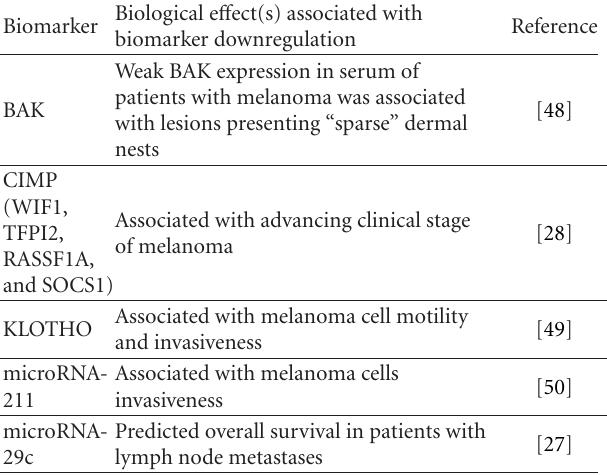
Table 2: E ff ects of candidate of tumor suppressor biomarkers in melanoma